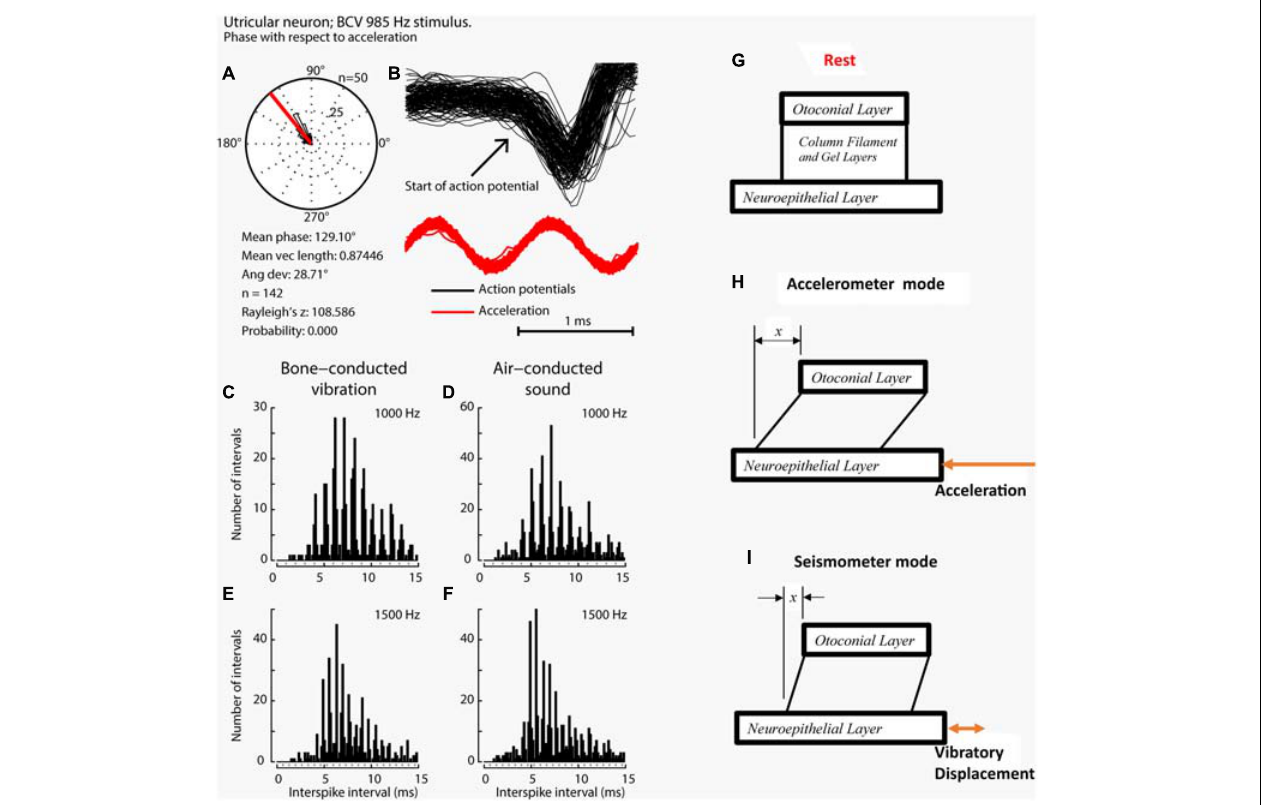
FIGURE 6 | Phase locking of a single primary utricular neuron. (A,B) Time series of successive action potentials of the neuron to bone-conducted vibration (BCV) at 985 Hz. Panel (B) shows 142 action potentials superimposed and the onset of each successive action potential is shown by the arrow. The red trace shows the x channel of the 3D linear accelerometer. The neuron is locked to a narrow phase band of this stimulus. Panel (A) shows the circular histogram of the phases of the action potentials clustered around a mean of 129.1 ◦ , with angular deviation 28.7 ◦ . The test of circular uniformity (Rayleigh’s z) , is highly significant showing the probability of a uniform phase distribution is < 0.001. The neuron misses some cycles, but when it fires is locked to the stimulus waveform. Reproduced from Curthoys et al. (2019a) with permission of Elsevier. (C–F) Histograms of interspike intervals to show phase locking in the same utricular afferent neuron in guinea pig at two high frequencies of BCV (C,E) and air- conducted sound (ACS) stimuli (D,F) . The bin width is 0.16 ms. The dots below each histogram show integral multiples of the period for the given stimulus frequency. The clustering around these integral multiples demonstrates phase locking at both frequencies. Reproduced from Grant and Curthoys (2017) with permission of Elsevier. (G–I) To show the differences in otolithic stimulation between the accelerometer and seismometer modes. (G) Show the gross schematic. (H) and (I) Show the otolithic macula in motion in relation to an inertial reference. In the low frequency accelerometer mode, not only is neuroepithelial layer (NEL) in motion, the otoconial layer (OL) s also in motion lagging behind the NEL due to its inertia, resulting in relative displacement between the two layers. This is also true for the otolith in the seismometer mode (I) , where it is the NEL that is in motion with the OL remaining at rest or only slightly in motion, again due to its inertia (I)